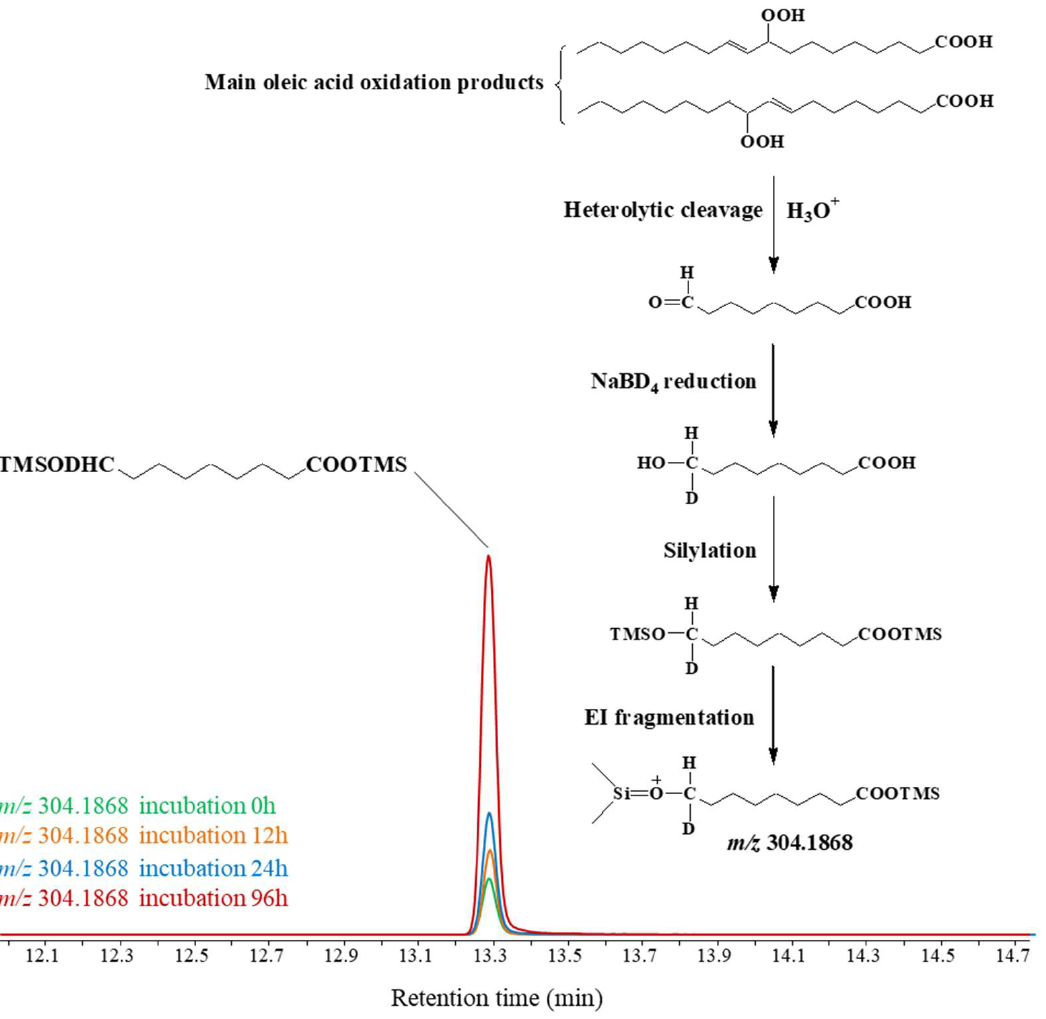
Figure 6. TOF chromatograms showing the production of increasing amounts of deuterated ω - hydroxynonanoic acid (arising from heterolytic cleavage of oleic oxidation products) during incuba- tion of dust analogue in fresh water.